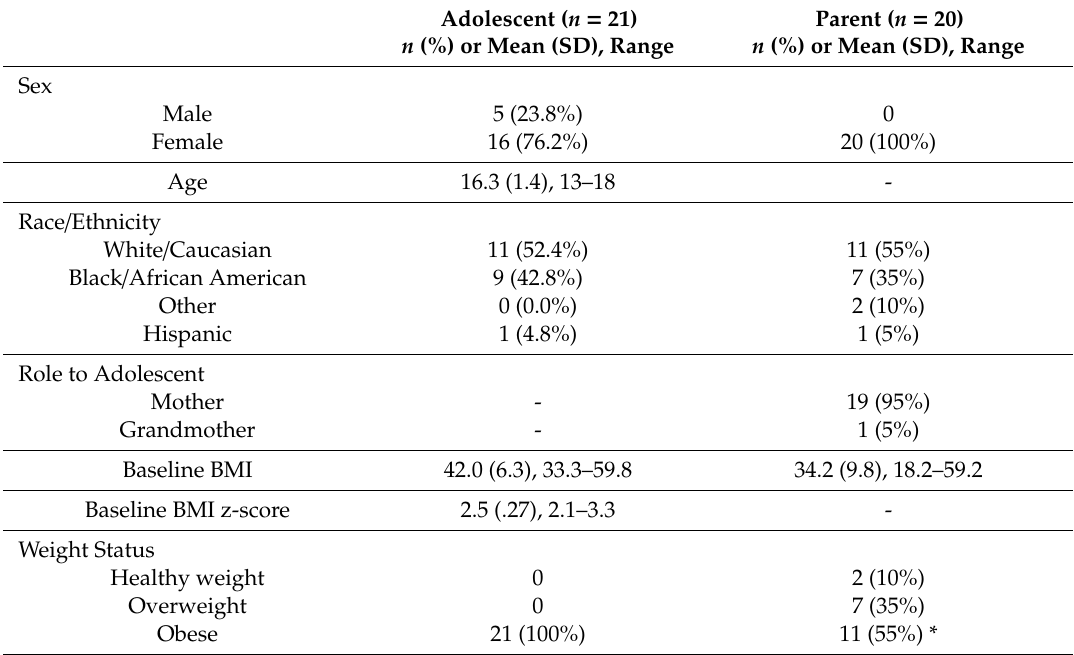
Table 3. Baseline characteristics of adolescents and